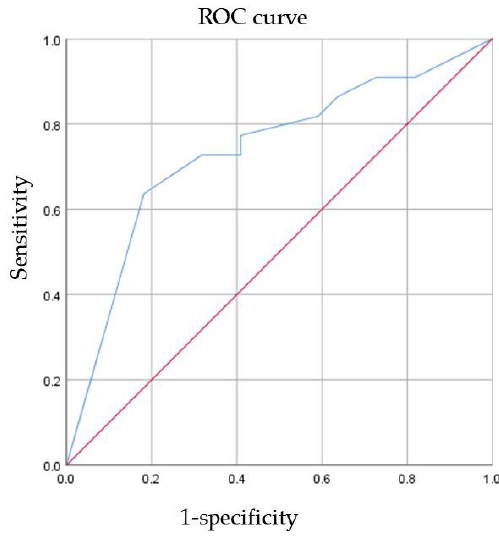
Figure 2. The ability of AR to predict pCR. ROC receiver operating characteristic, AR androgen re- ceptor, pCR pathological complete